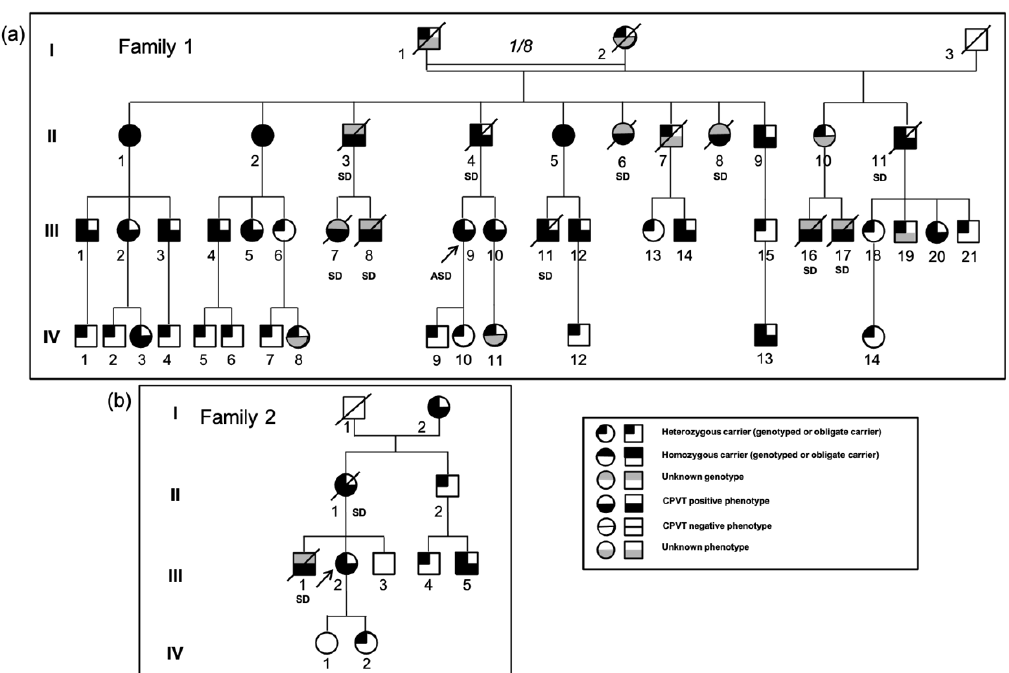
Figure 1. Pedigrees of two families. ( a ) Pedigree of Family 1; ( b ) Pedigree of Family 2. Squares and circles indicate males and females, respectively, and slashes indicate deceased individuals. For Family 1, only deceased and living D3291V carriers were indicated; thirty healthy genotype negative carriers were excluded. Genotypes and phenotypes are indicated with black and grey boxes. SD: Sudden death, ASD: Aborted Sudden Death.